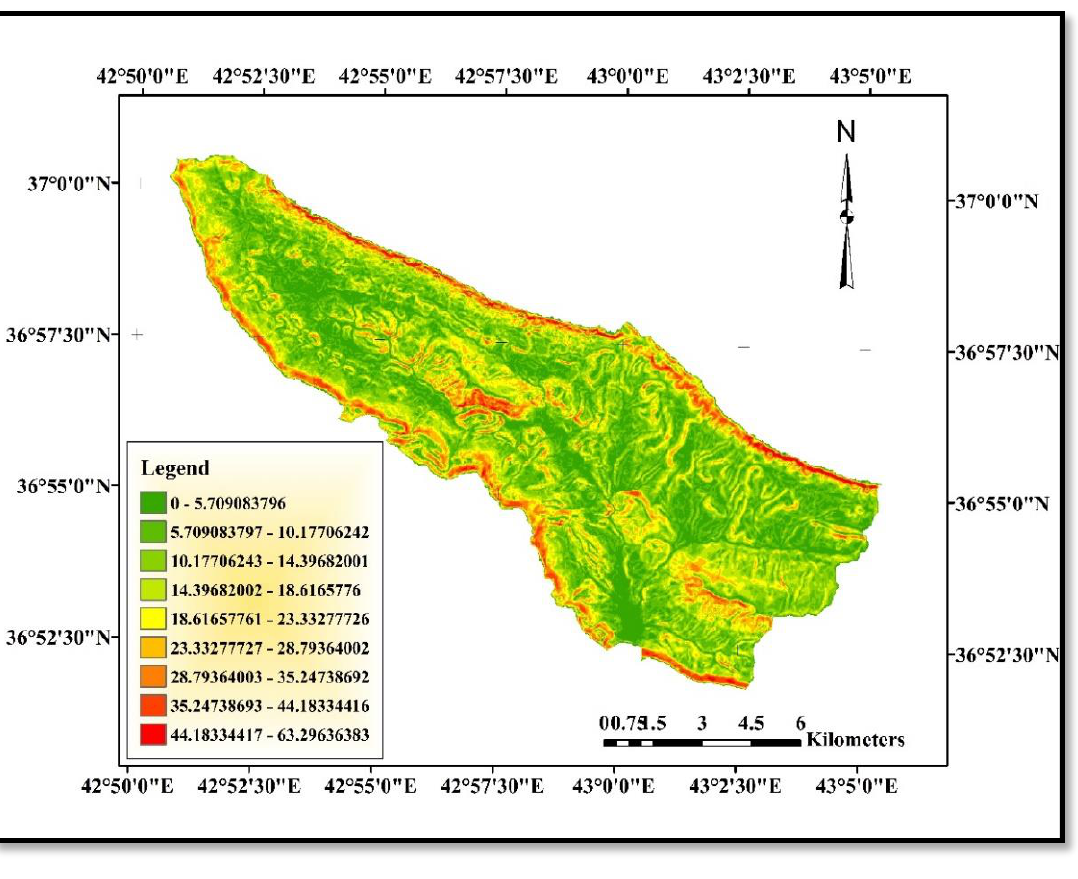
Figure 3. Slope of Duhok Dam Basin.